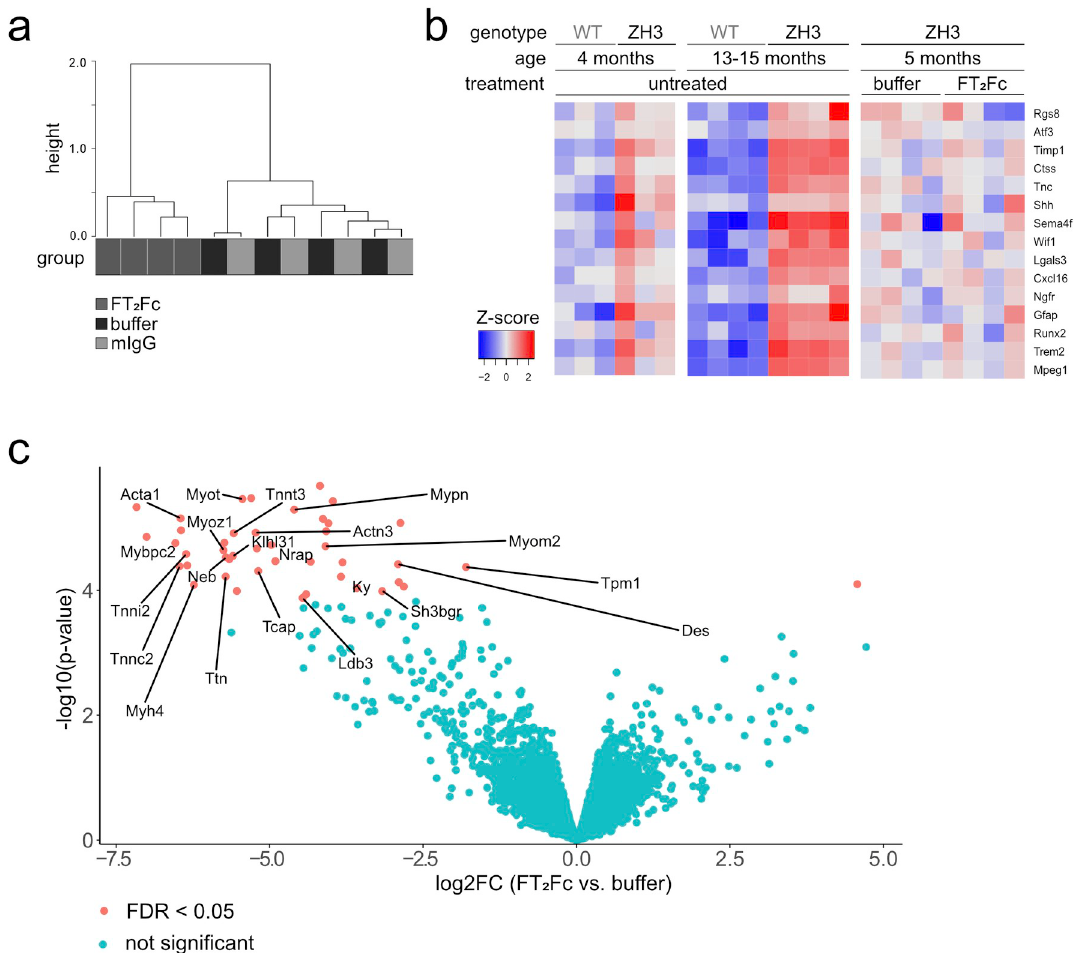
Fig 6. RNA sequencing of sciatic nerves from FT 2 Fc treated mice. (a) Hierarchical clustering analysis based on the 100 genes with the highest variance across all samples showed a separation between FT 2 Fc treated mice and control mice (n = 4 per treatment). (b) Heatmap of the selected repair Schwann cell genes. The red-blue colour key is based on the row-wise Z-scores. 4 months old ZH3 mice (n = 3) showed a mild, 13–15 months old ZH3 mice (n = 4) a pronounced upregulation of these genes when compared to age-matched WT mice. No difference was detected in FT 2 Fc treated ZH3 mice (n = 4) compared to buffer treated mice (n = 4). (c) Volcano plot showing differentially expressed genes in sciatic nerves of FT 2 Fc treated compared to buffer treated mice. Genes with FDR < 0.05 were considered significantly up- or downregulated (43 downregulated genes, 1 upregulated gene). Genes involved in actin binding are labelled in the plot. Log2FC = log2 fold change.